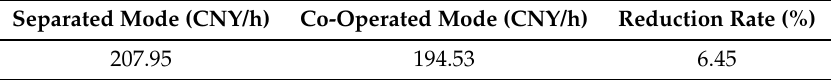
Table 3. Comparison of mean scheduling cost between separated mode and co-operated mode.